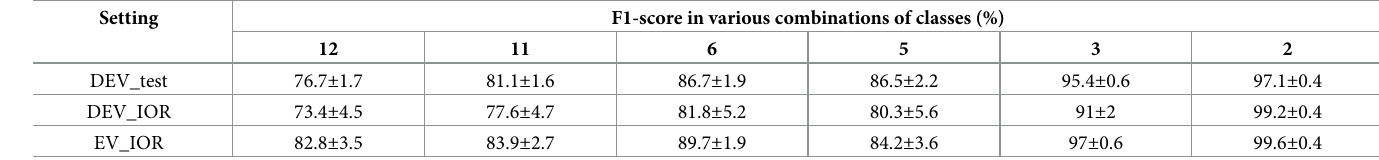
Table 5. F1-score of the DEV_test and subsets of DEV (DEV_IOR) and EV datasets (EV_IOR) for IOR calculation. F1-score values (in percentage) are given for dif- ferent combinations of classes. The numbers provided for DEV_test is the same as the numbers in Table 4. They are presented here again for easier comparison. Since we do not have ‘missed’ segments in the DEV_test data, these segments are removed when calculating the F1 score of DEV_IOR and EV_IOR datasets.